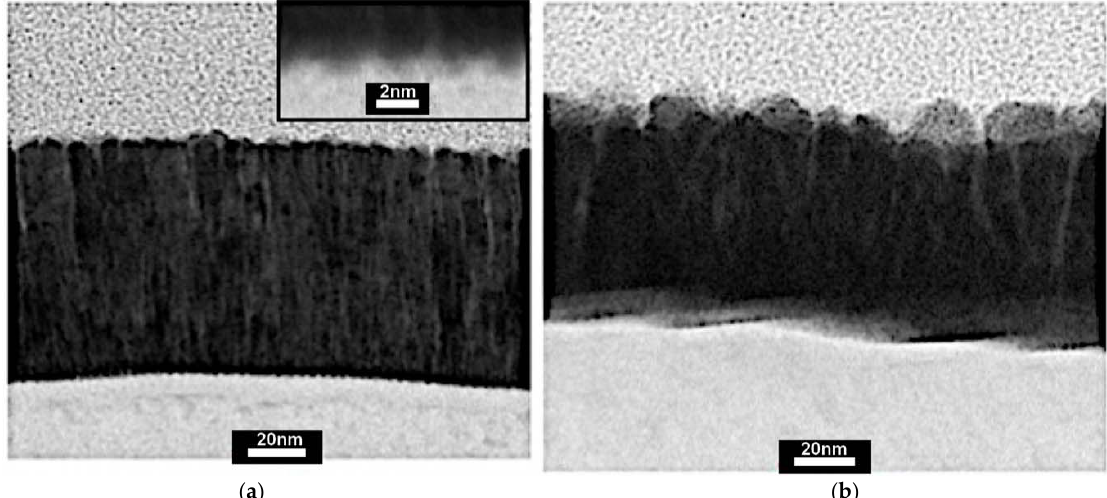
Figure 1. STEM image of the samples produced by Pt-C and Pt targets sputtering using DC regime without bias voltage applied to the substrate. ( a ) Pt-C film deposited on Ti substrate. Scale bar is 20 nm. (The inset shows an enlarged image of the interface zone. Scale bar is 2 nm). ( b ) Pt film deposited on Ti substrate. Scale bar is 20 nm.